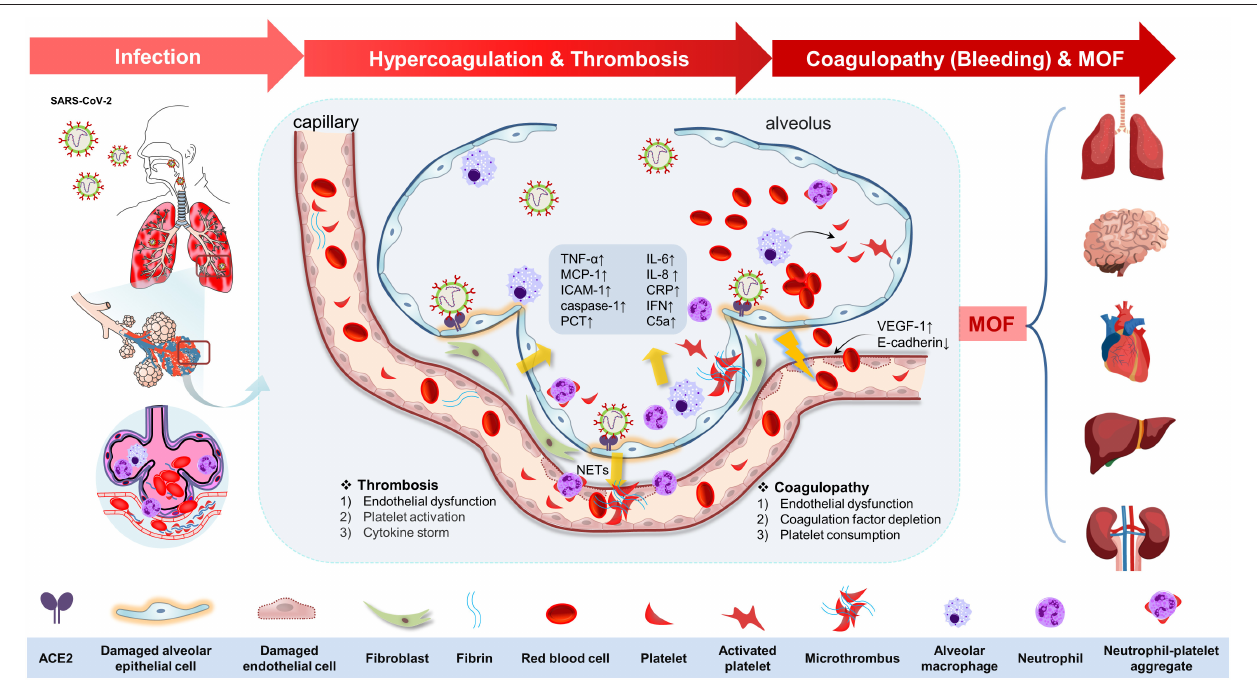
FIGURE 1 | The potential pathophysiological evolutions underlying severe acute respiratory syndrome coronavirus 2 (SARS-CoV-2) infection, linking pulmonary inflammation, multiple organ failure, and thrombosis and coagulopathy. The potential pathophysiological evolutions underling SARS-CoV-2 infection was summarized as the following three stages: infection, hypercoagulation, and thrombosis, coagulopathy (bleeding tendency), and multiple organ failure. First, the SARS-CoV-2 could transmit through the respiratory tract in the infected host by angiotensin-converting enzyme 2 (ACE-2) in the epithelial cells in the trachea or lung tissues. The viral proliferation and dissemination within the lung tissue lead to in situ endothelial cell injury and platelet and immune system activation. Second, endothelial dysfunction [upregulation of vascular endothelial growth factor receptor 1 (VEGF-1) and downregulation of E-cadherin] elicits the inflammation response and platelet activation to seal the damaged endothelium. Platelet activation was mediated by mitogen-activated protein kinase (MAPK) pathway activation and thromboxane generation, which further induces neutrophil extracellular trap (NET) formation, contributing to the microthrombus with fibrin. Additionally, immune defense and cytokine storm also participate in this process by means of immunothrombosis. This process is characterized by upregulation of tumor necrosis factor- α (TNF- α ), monocyte chemotactic protein 1 (MCP-1), intercellular cell adhesion molecule-1 (ICAM-1), caspase-1, interleukin-6 (IL-6), IL-8, C-reactive protein (CRP), interferon (IFN), C5a, procalcitonin (PCT), etc. Antiplatelet therapy is of therapeutic potential at this stage. Third, coagulopathy (bleeding tendency) was associated with endothelial dysfunction, coagulation factor depletion (including fibrinogen and others), and platelet consumption. Finally, all of these changes in COVID-19 drive the progress of multiple organ failure (MOF), including brain, heart, lung, liver, and